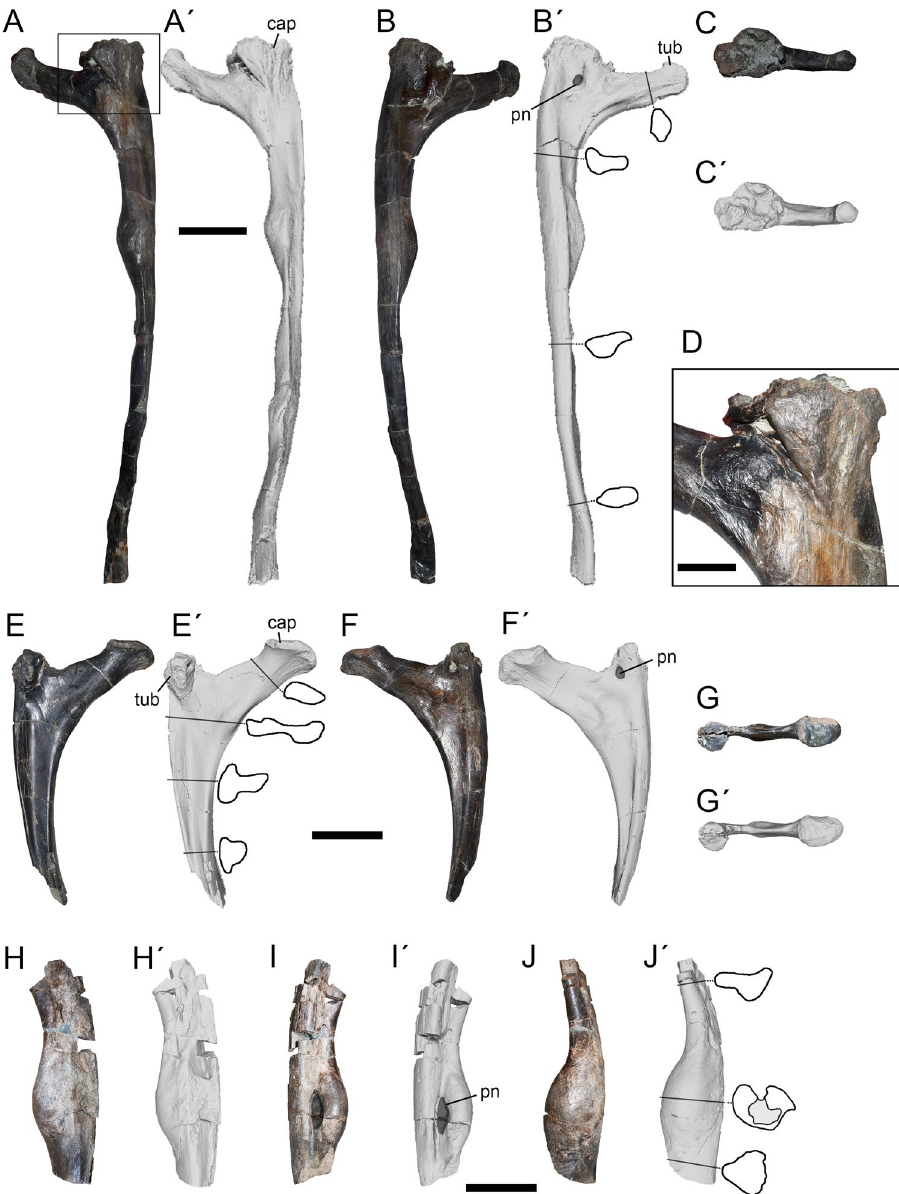
Figure 11. First ( A – D ), second ( E – G ) and sixth ( H – J ) dorsal ribs of Maip . First dorsal rib in anterior ( A, A´ ), posterior (B, B´ ) and proximal ( C, C´ ) views and close-up of the proximal end ( D ). Second dorsal rib in anterior ( E, E´ ), posterior ( F, F´ ) and proximal ( G, G´ ) views. Sixth dorsal rib in anterior ( H, H´ ), posterior ( I, I´ ) and medial ( J, J´ ) views. Scale bars: 5 cm. Abbreviations: ap, anterior process; cap, capitulum; pn, pneumatopore; tub,